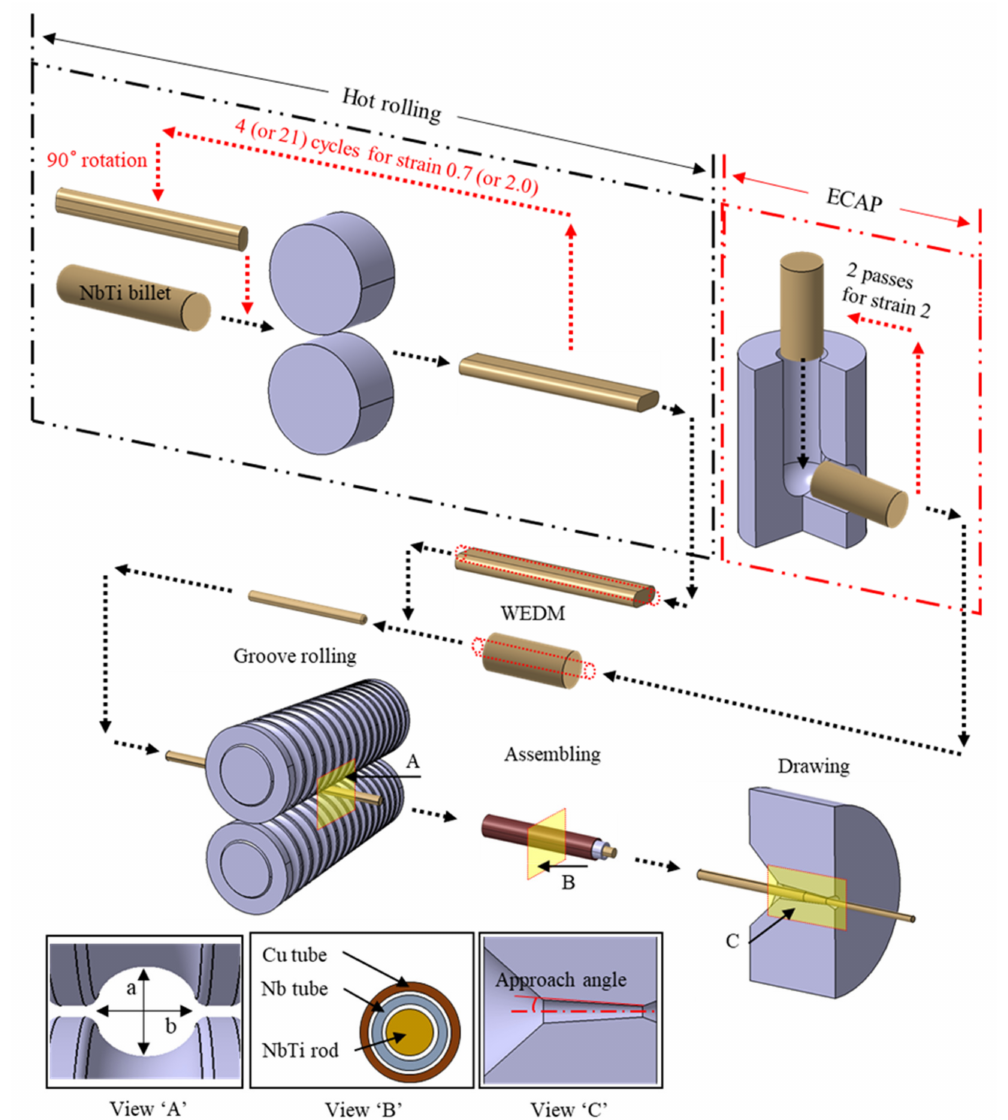
Figure 1. Schematics showing the whole process, include hot rolling, equal channel angular pressing (ECAP), groove rolling and drawing. Hot rolling and ECAP were conducted at 600 ◦ C and room temperature,